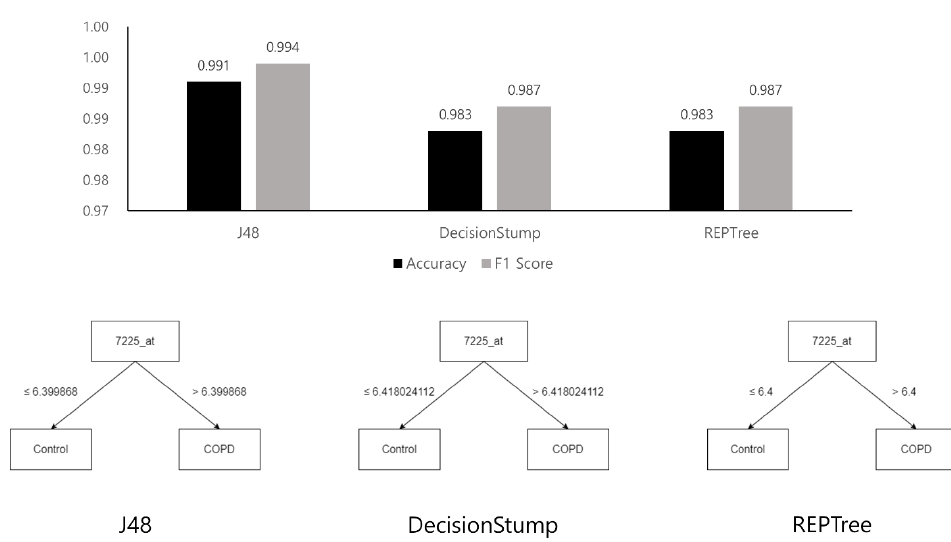
Figure 4. Chart visualizing the performance of the three decision tree models and their structures.